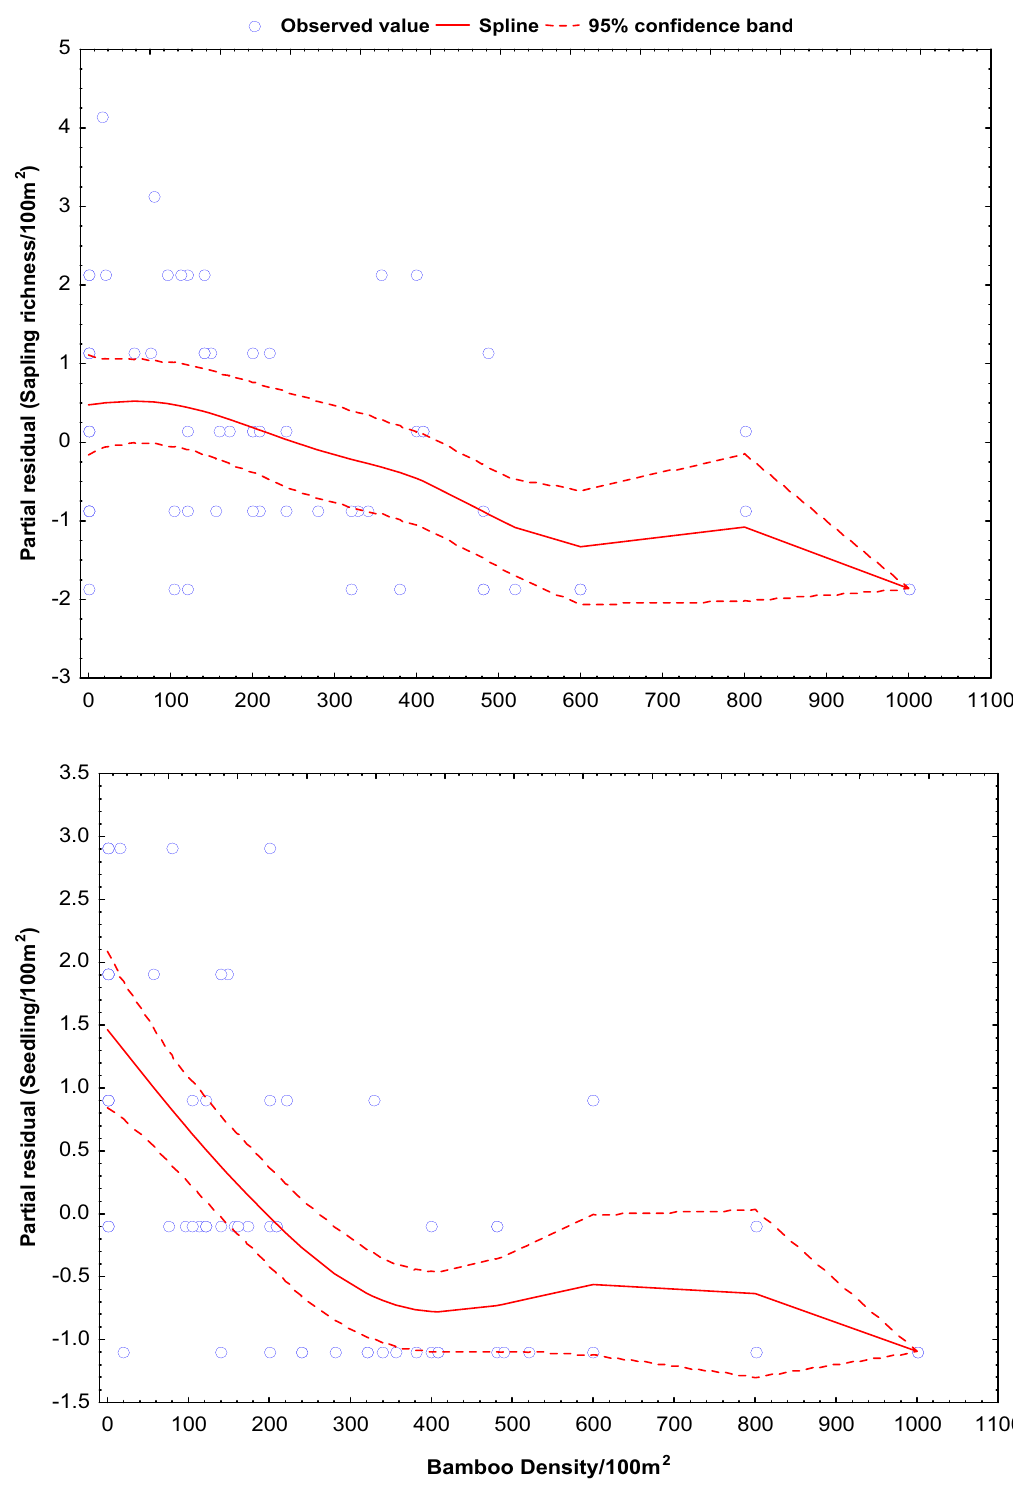
Figure 3. Predicted changes in species richness of tree sapling and seedlings with respect to increasing density of bamboo. The significance of the smooth best fit model generalized the changing slope as GAM coefficient (β), standard error (SE) and coefficient of determinant (R 2